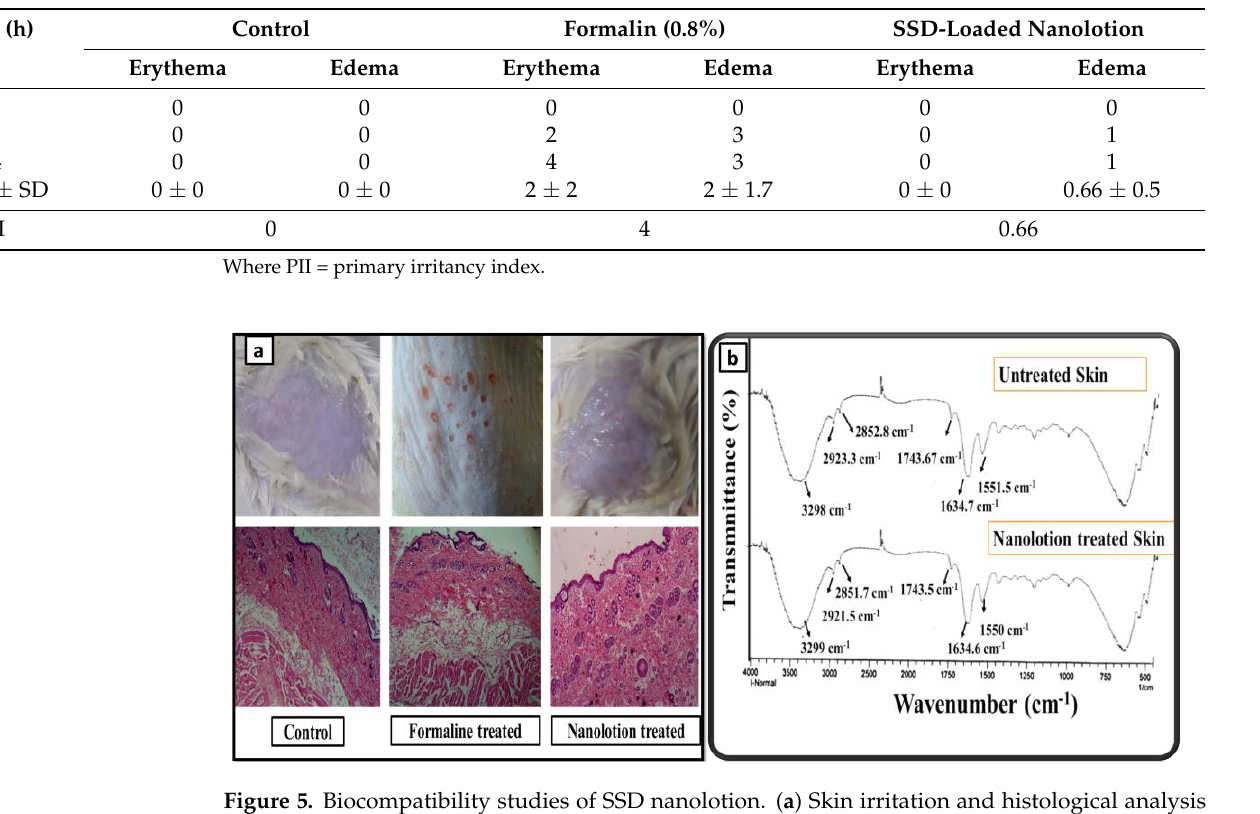
Table 5. Stability studies for SSD-based